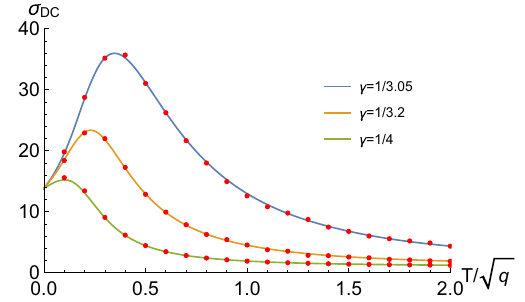
Fig. 3 σ DC asthefunctionof T fordifferenttemperature.Blue,yellow and green lines are the analytical solutions obtained from (17)and red dots are the numerical solutions by solving